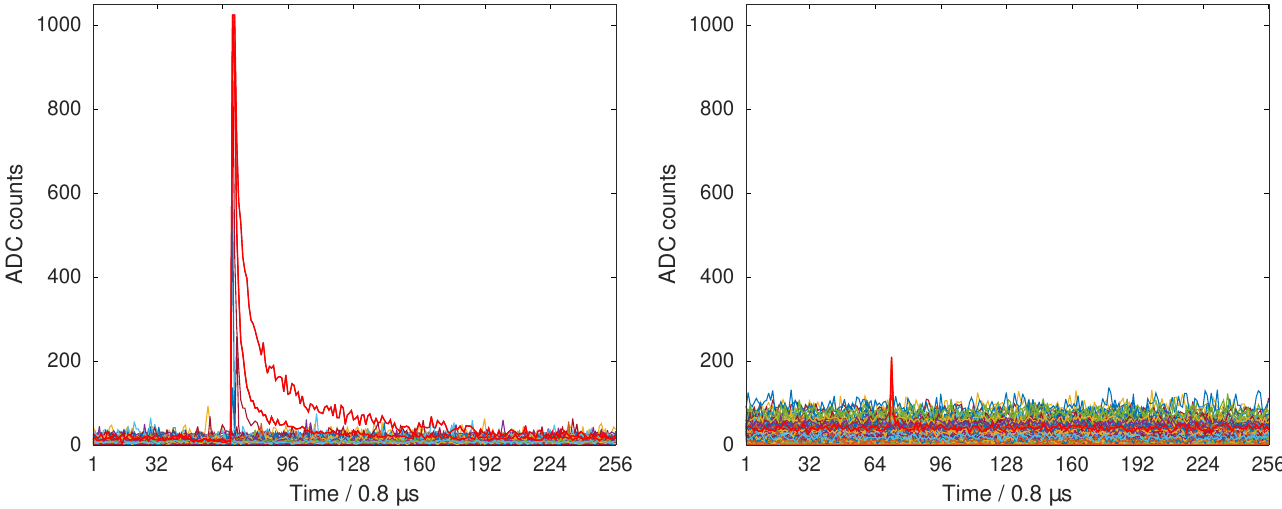
Figure 2. Examples of waveforms of instant track-like flashes. Left : typical waveforms with ADC codes reaching their maximum values in one or more channels (shown in red). Right : a weak TLF on a strong background registered during a full-Moon night. One time tick equals 0.8 µ s, the total duration of a record is 204.8 µ